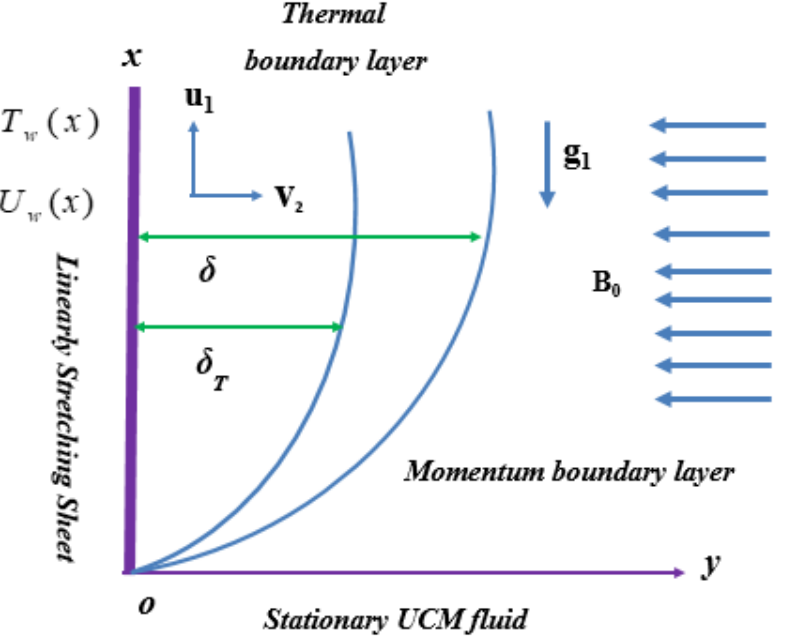
Figure 1. The flow diagram and coordinate system.